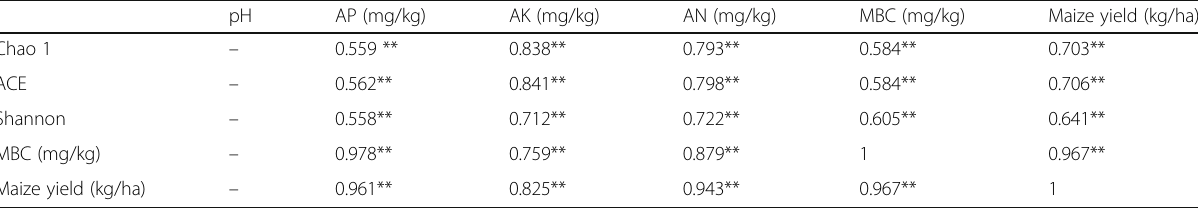
Table 4 Correlation between microbial diversity parameters, soil properties, and maize yield